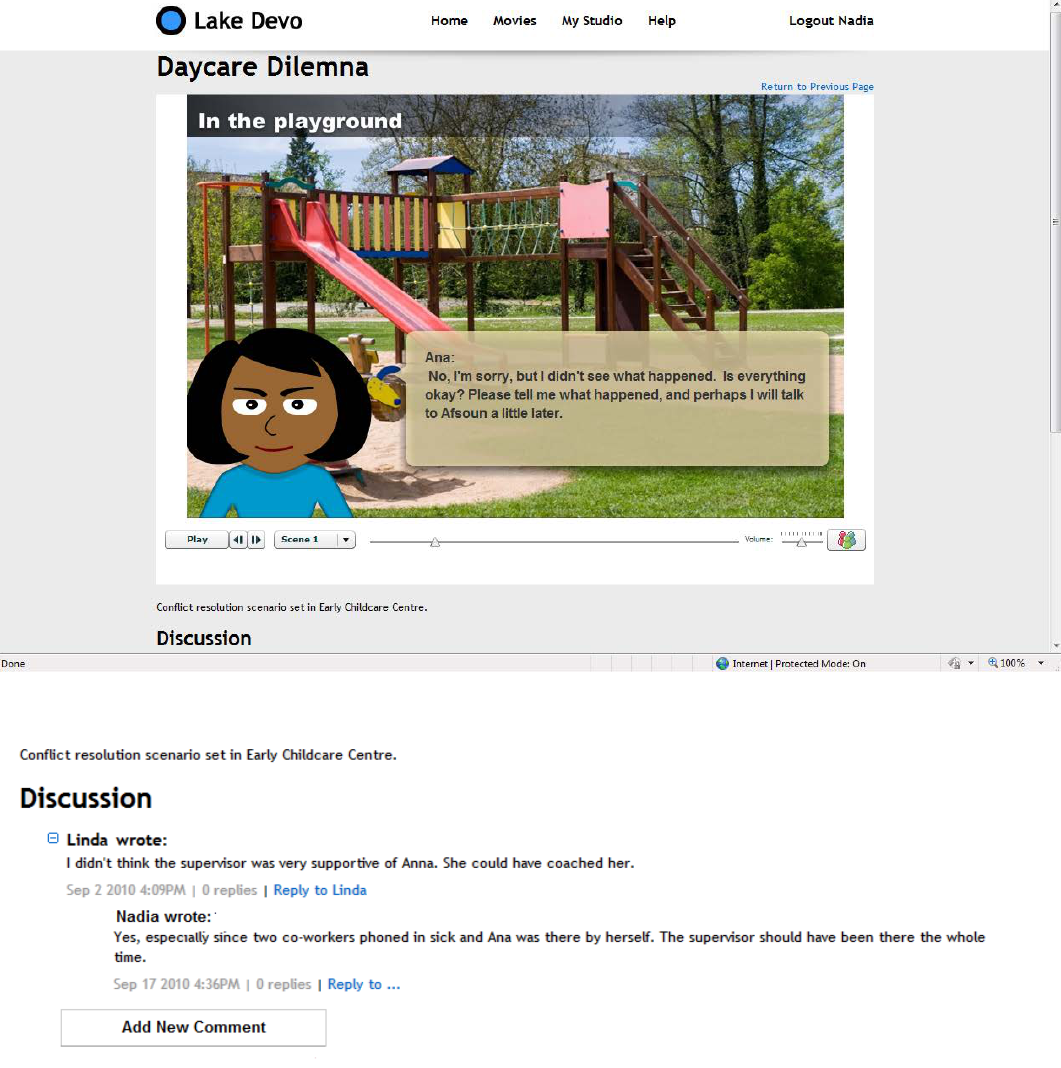
Figure 5 . Screenshot of the Lake Devo Role-play Debrief